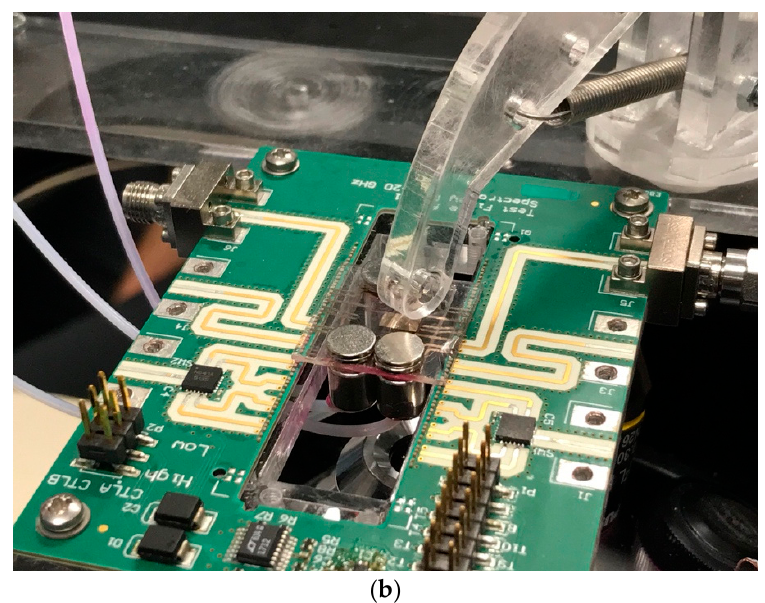
Figure 7. ( a ) The manufactured microwave-microfluidic chip (20 mm × 20 mm); ( b ) The microwave- microfluidic chip placed on top of the microwave-microfluidic platform and fixed by the spring-loaded plastic pin.